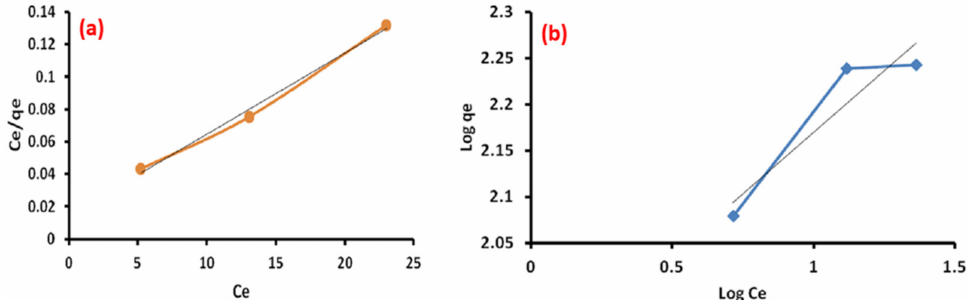
Figure 13. Hydroxyapatite/gold nanocomposite to adsorb MB: ( a ) Langmuir isotherm model; ( b ) Freundlich isotherm model